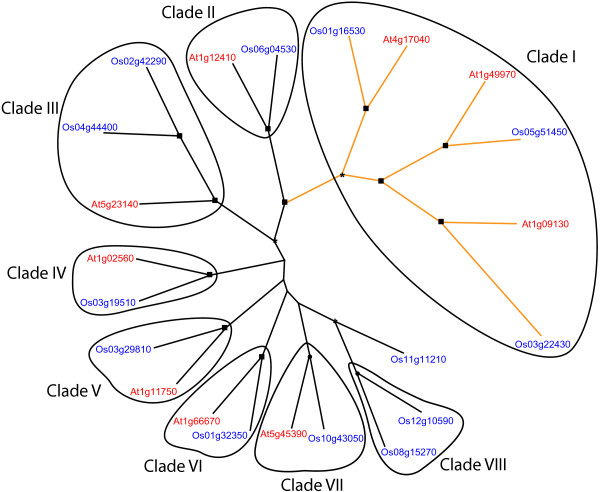
Unrooted N-J tree computed from multiple sequence alignments of Arabidopsis (red) and rice (blue) Clp protease domains. Clp protease-like domains were aligned using ClustalW [95] program and the alignments were exported to Phylip package [96] for representing the Neighbor-Joining tree (see methods). The colors and circles represent different evolutionary clades identified in the analysis (see text for details). Clade I is represented in orange, while clades II-VIII are shaded in black. For clarity, bootstrap values were replaced with symbols representing bootstrap percentages >50%. Bootstrap values between 50–60% are represented by an asterix, circles represent bootstrap values from 60%–80% while bootstrap values >80% are represented by rectangles. Gene names correspond to those in Additional files 1 and 2. For brevity, rice gene names have been shortened to OsXXg##### instead of LOC_OsXXg#####, XX referring to chromosome 1–12 and a 5 digit number assigned to each gene.